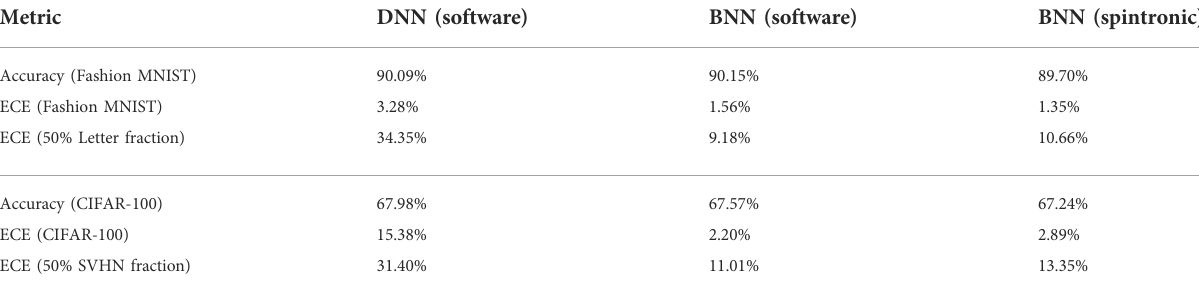
TABLE 3 Accuracy and expected calibration error of trained networks.